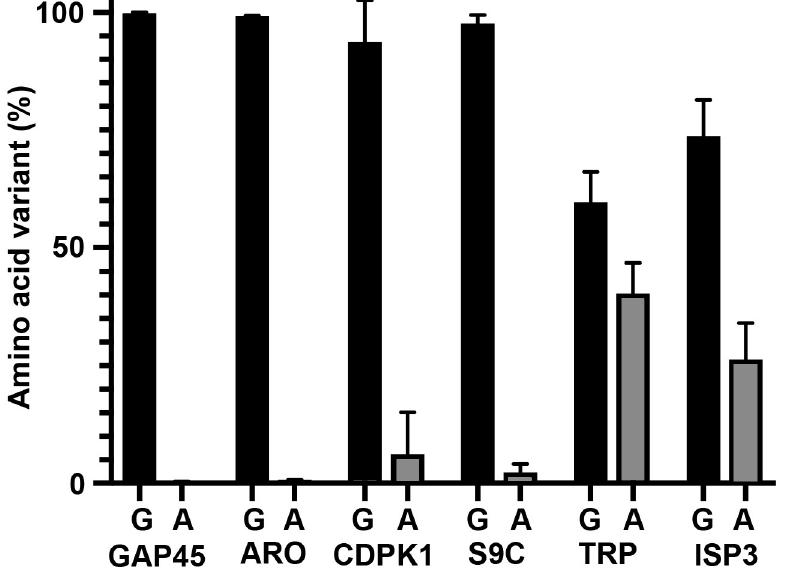
Fig 4. A viability screen of parasites containing either G2G or G2A at the myristoylation site in NMT substrates. A CRISPR/Cas-9 approach was used to insert G2A or G2G codons at the start of selected genes (see S4 Fig for details). Six genes were targeted using a 50:50 ratio of repair plasmids carrying a codon for G2G (Gly; silent mutation) or G2A (Ala, abolishing the myristoylation site). Illumina sequencing of products amplified using integration specific PCR primers was used to determine the distribution of each form in the parasite population following transfection (see S1 Data for the numbers). Each gene targeting was performed at least twice ( gap45 , n = 3) with 2 different guides (except for aro and gap45 when 2 transfections with the same guide were performed). ARO, armadillo domain–containing rhoptry protein; CDPK1, calcium-dependent protein kinase 1; GAP45, glideosome-associated protein 45; ISP3, IMC sub-compartment protein 3; TRP, tetratricopeptide repeat